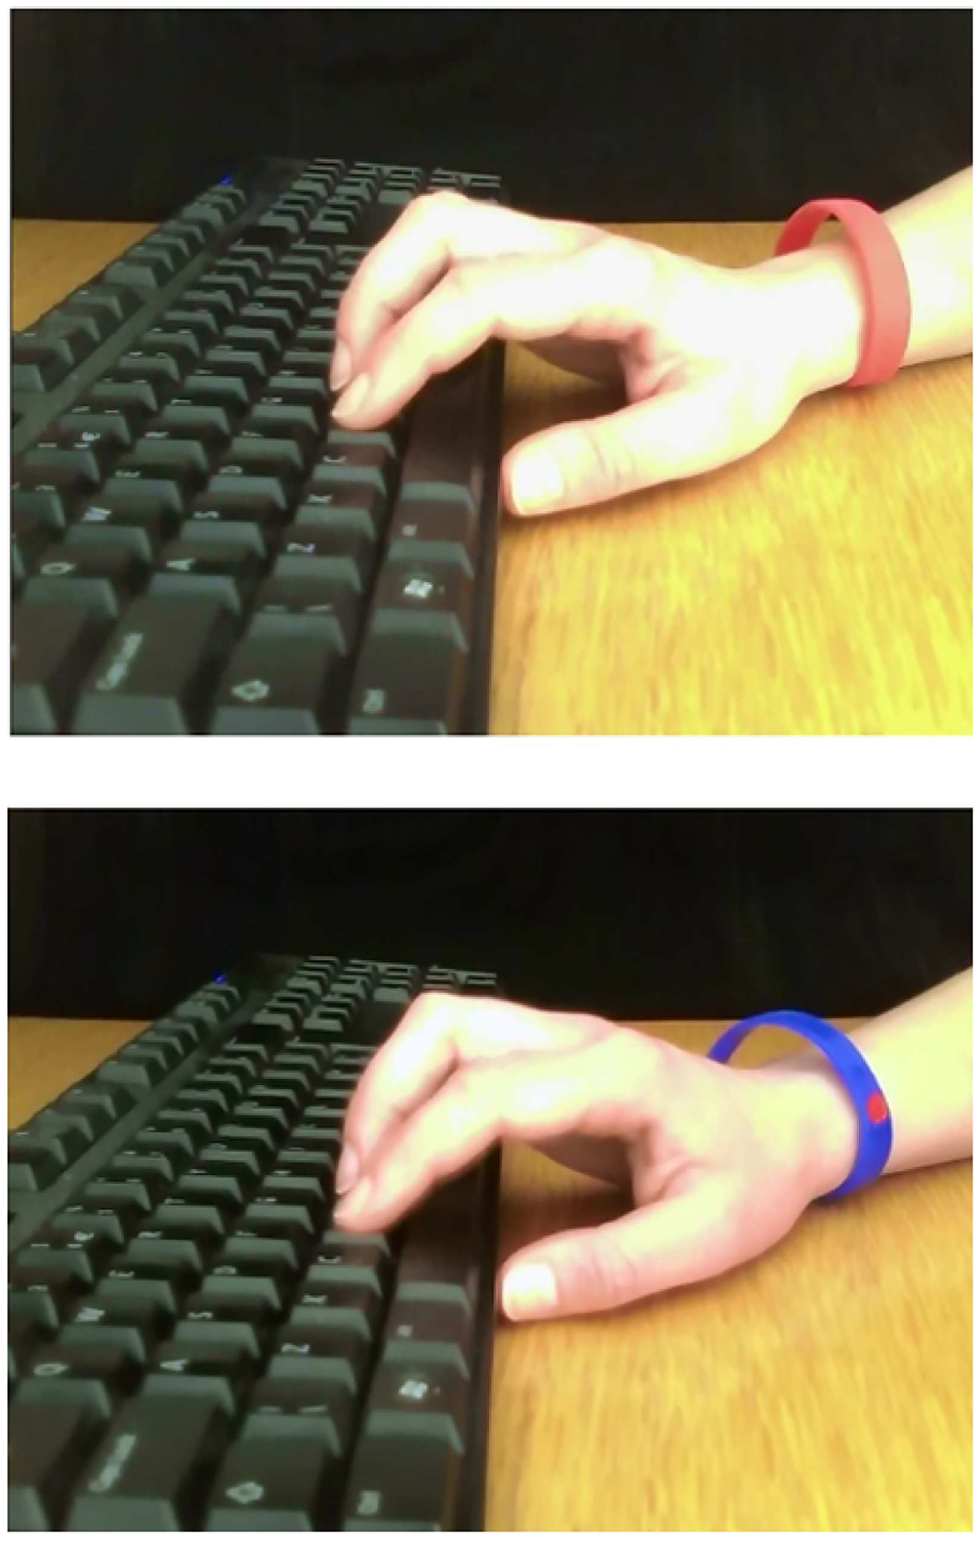
Fig 1. Ingroup (top) and outgroup (bottom) stimuli (single framesfrom the videos used in the ingroup and outgroup